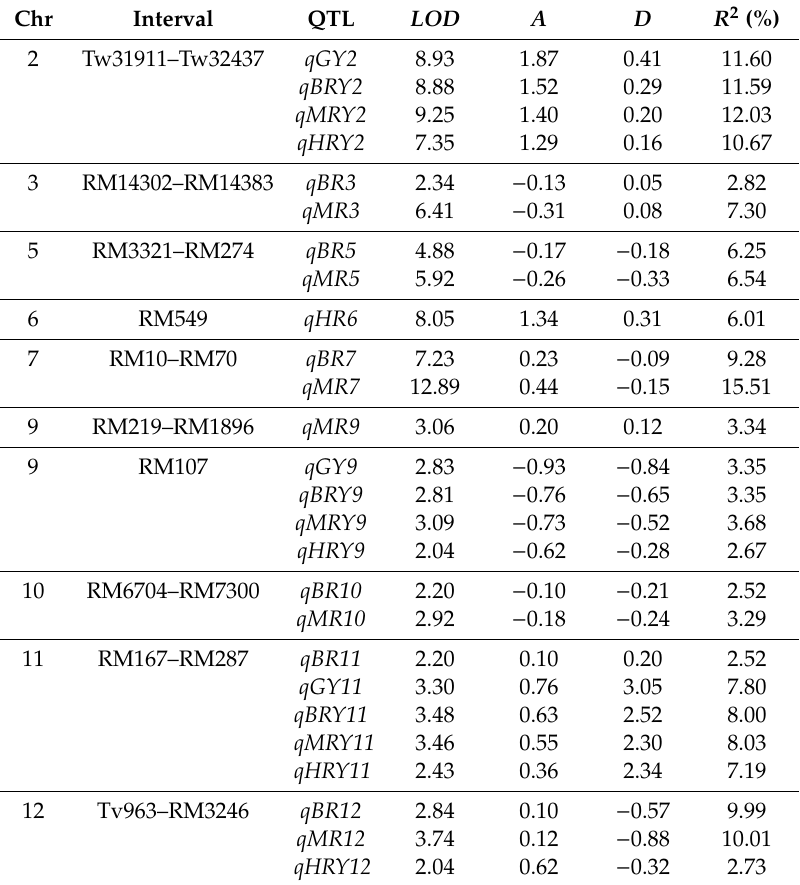
Table 5. QTLs for seven traits detected in the RH-F 4:5